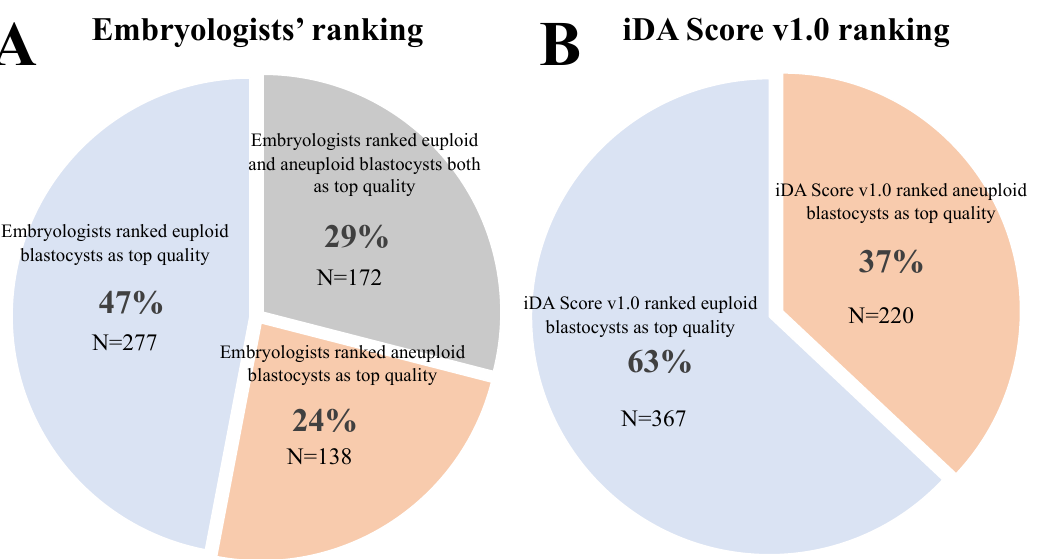
Figure 6. Association between the top-ranked blastocysts within each cohort according to: ( A ) the embryologists’ ranking, and ( B ) iDAScore v1.0 ranking and their chromosomal constitution.